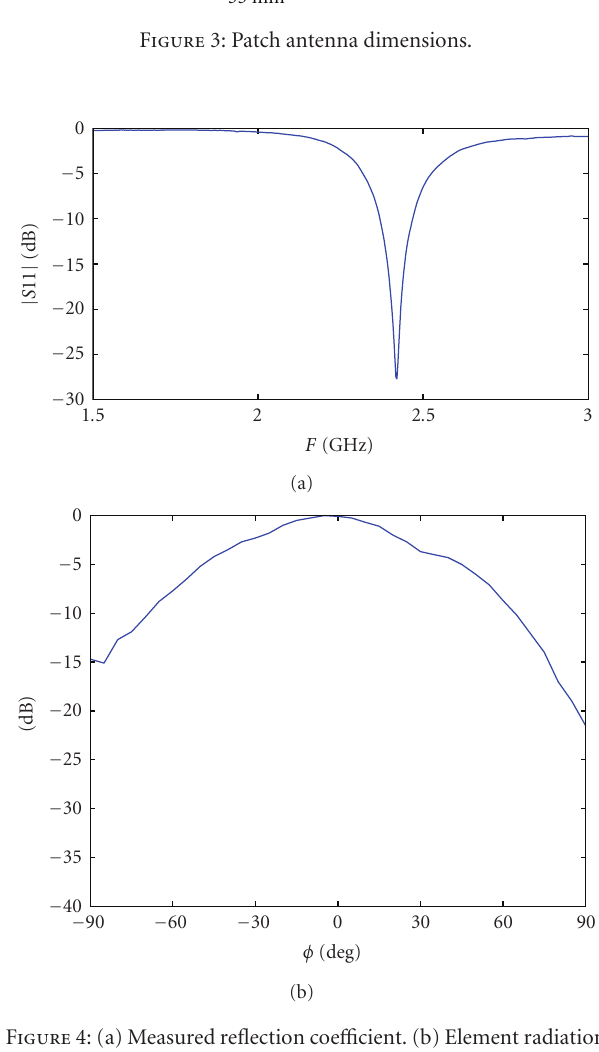
Figure 4: (a) Measured reflection coe ffi cient. (b) Element radiation